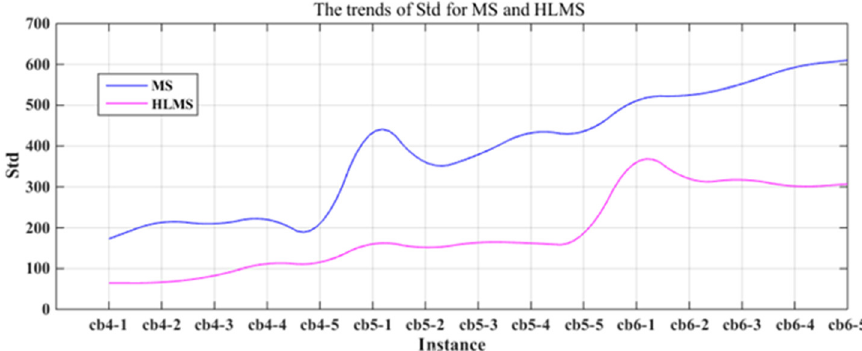
Figure 9. The trends of Std for MS and HLMS on Test set III (cb4–cb6). Table 6. The results of HLMS with 6 comparative algorithms for Test set IV.